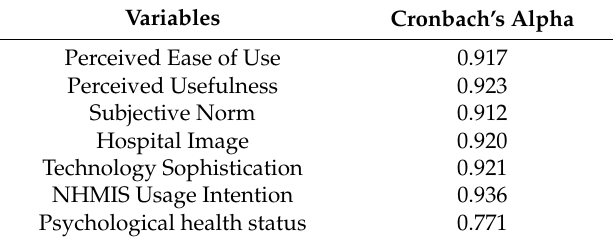
Table 3. Research Operational Definition.